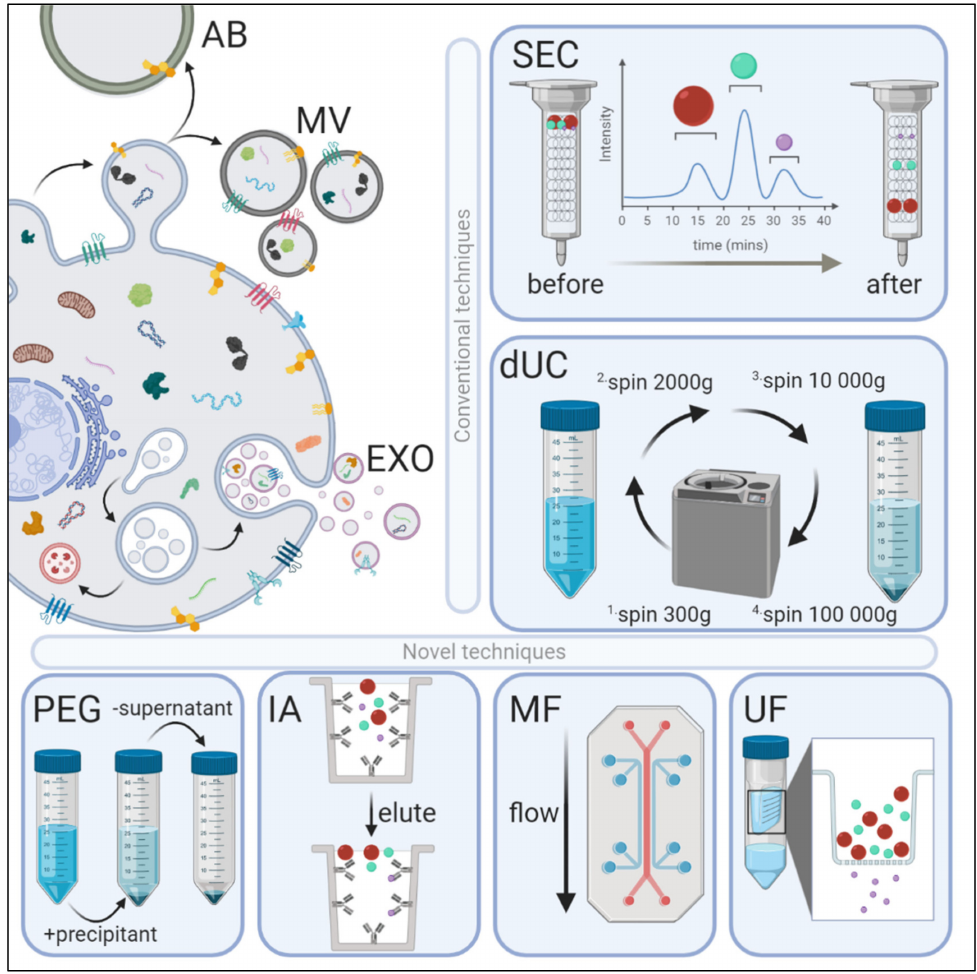
Figure 1. Extracellular vesicle (EV) biogenesis, subpopulations, and conventional and novel methods of exosome isolation. EVs are categorized into three main types depending on their site of origin, density, expression of markers, and / or size. Apoptotic bodies (AB) are released by the blebbing of an apoptotic cell membrane (500–5000 nm); microvesicles (MV) are shed from the outward budding of the plasma membrane (100–1000 nm); and exosomes (EXO) are formed when multivesicular bodies fuse to the plasma membrane and release intraluminal vesicles (30–150 nm). EVs have variable: (1) protein expression profiles—EXOs are enriched with Fliotillin-1, ALIX, TSG101, CD81, CD63 and CD9 proteins, whereas MVs preferentially express MMP2 and ARF6; (2) lipidomic profiles—MVs are enriched with phosphatidylserine and cholesterol, EXOs with sphingomyelin and ceramide, and ABs by phosphatidylserine; and (3) distinct genomic and transcriptomic luminal cargo. Conventional